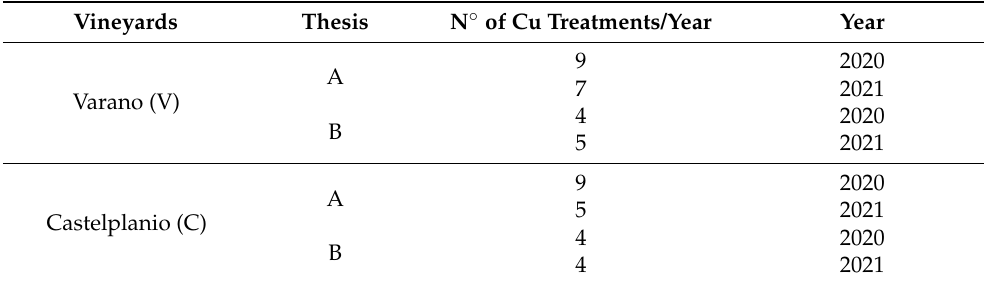
Table 1. Summary of the number of Cu-treatments carried out during the last two years in the vineyards under study.